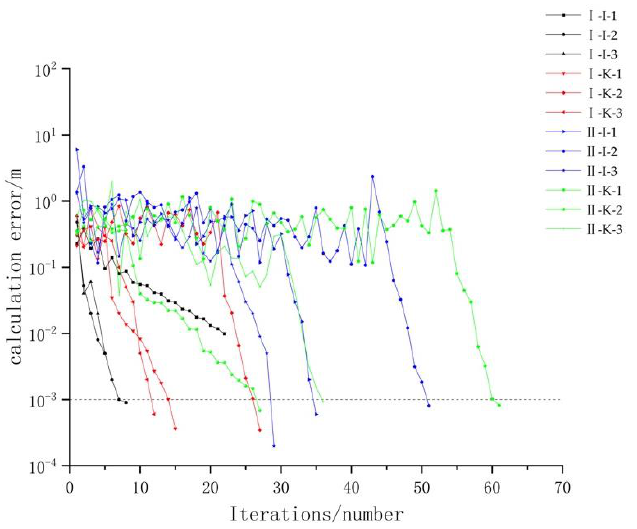
Table 4. Two working conditions.